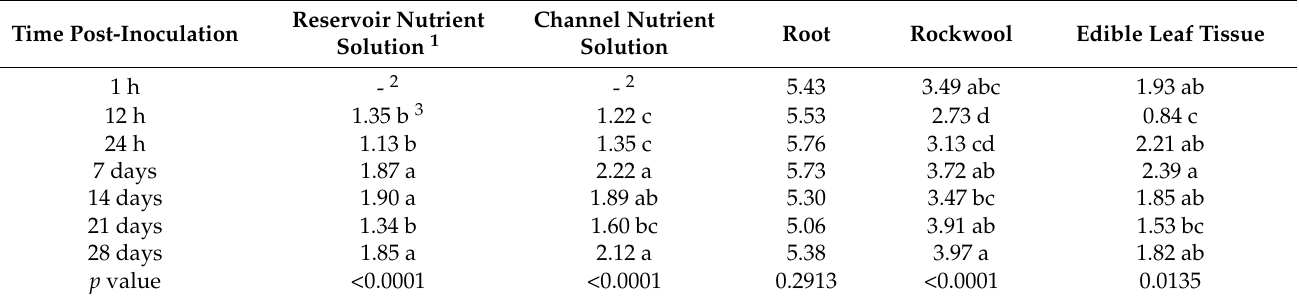
Table 4. Survival of Listeria monocytogenes (ATCC 19111) following the inoculation of the nutrient solution, simulating a sporadic contamination event, in the reservoir and the channels, root, rockwool, and edible leaf tissue over a 28-day growth